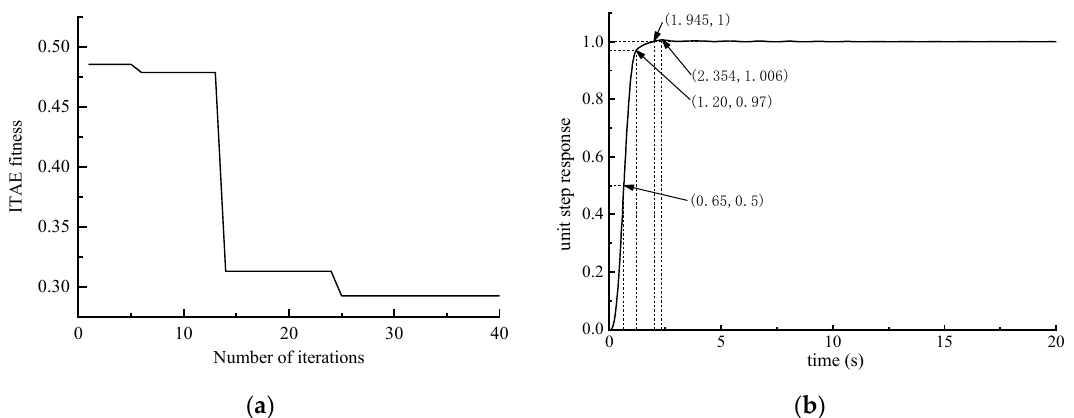
Figure 7. The optimized simulation results are as: ( a ) Iterative process of optimal individual fitness; ( b ) Simulation waveform of PID control based on beetle antennae search algorithm.